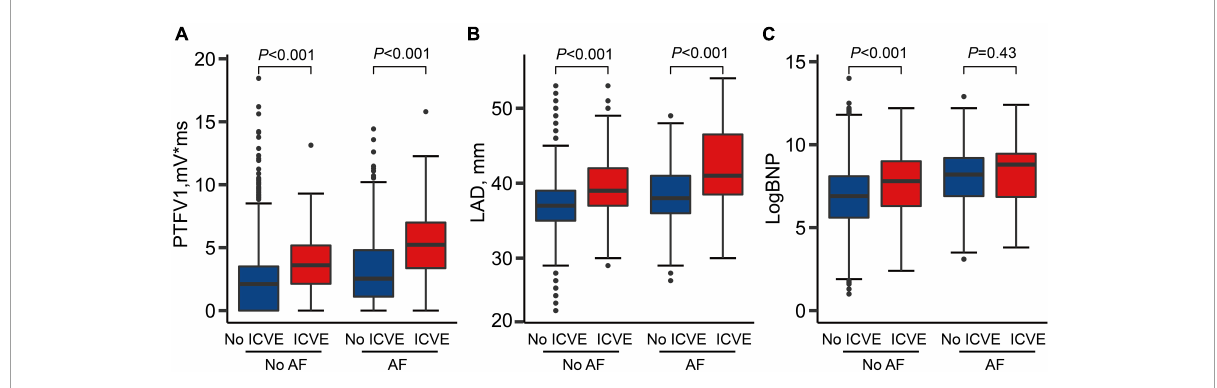
FIGURE2 Atrial cardiomyopathy markers by strata of atrial fibrillation (AF) and ischemic cerebrovascular events (ICVE). (A) PTFV1 levels by strata of AF and ICVE; (B) LAD levels by strata of AF and ICVE; (C) LogBNP levels by strata of AF and ICVE.